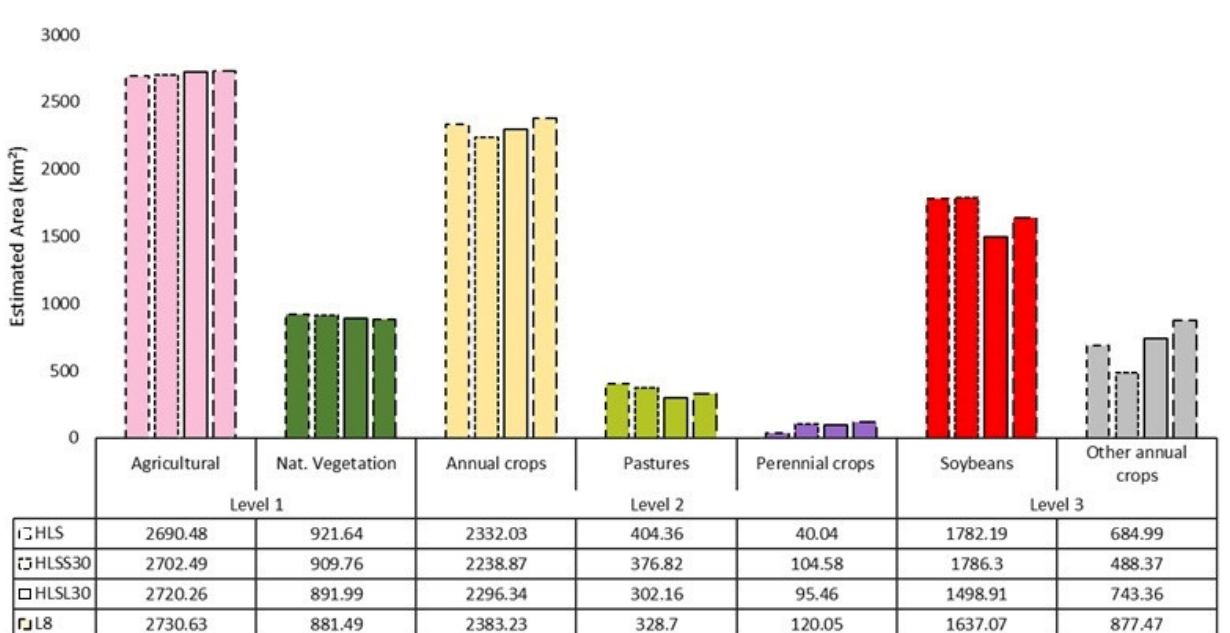
Figure 6. Estimated areas (km 2 ) for each class at each level, from the HLS, HLSS30, HLSL30, and L8 datasets.